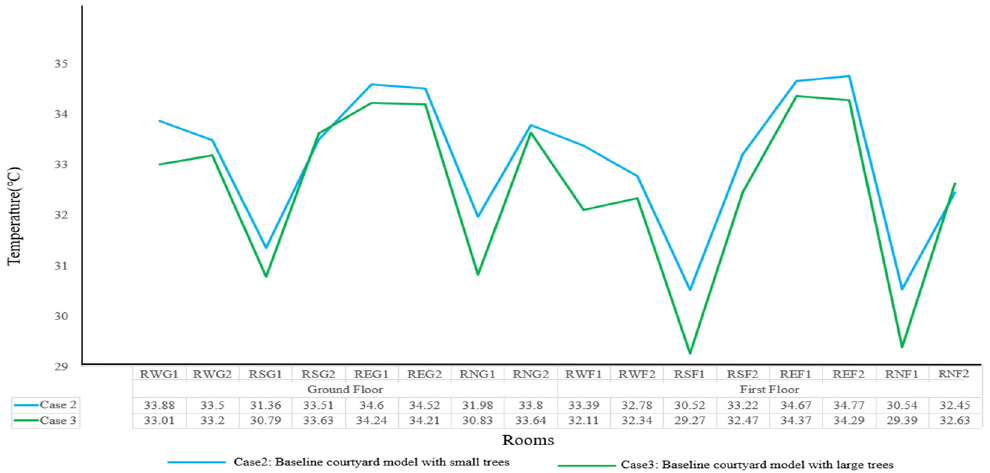
Figure 26. Comparison of air temperature for Case 2 and Case 3 in each room.